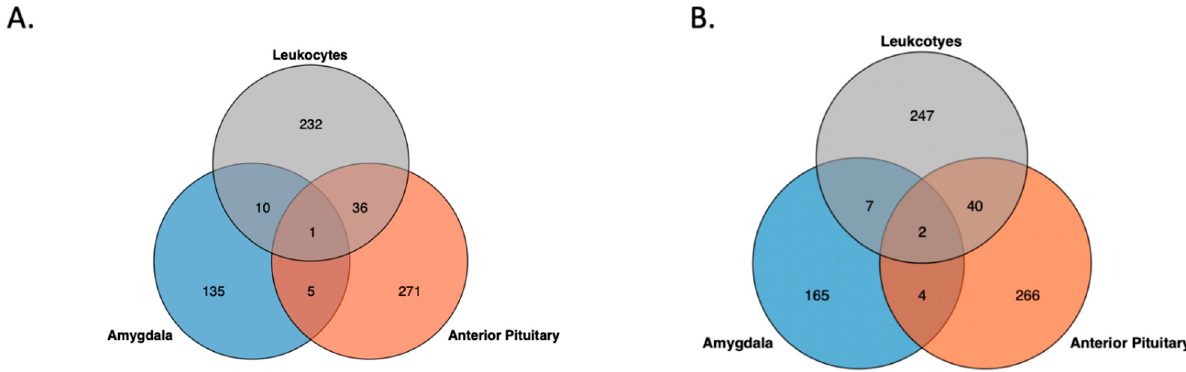
Figure 6. Overlap of gene bodies with high DNA methylation variation across the tissues and leukocytes in the Control ( A ) and Prenatally Stressed ( B ) group. Table 5. Highly variable 1 genomic features involved in the immune response biological process 2.